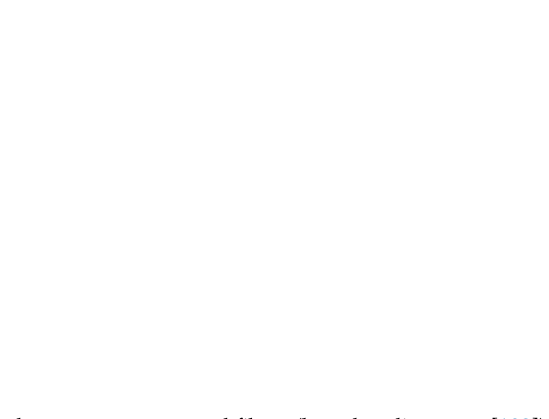
Figure 8. The schematic of energy absorption between concrete and fibres (based on literature [103]). (1) Fibre failure; (2) fibre pull-out; (3) fibre bridging; (4) concrete matrix/fibre debonding; (5) concrete matrix cracking.